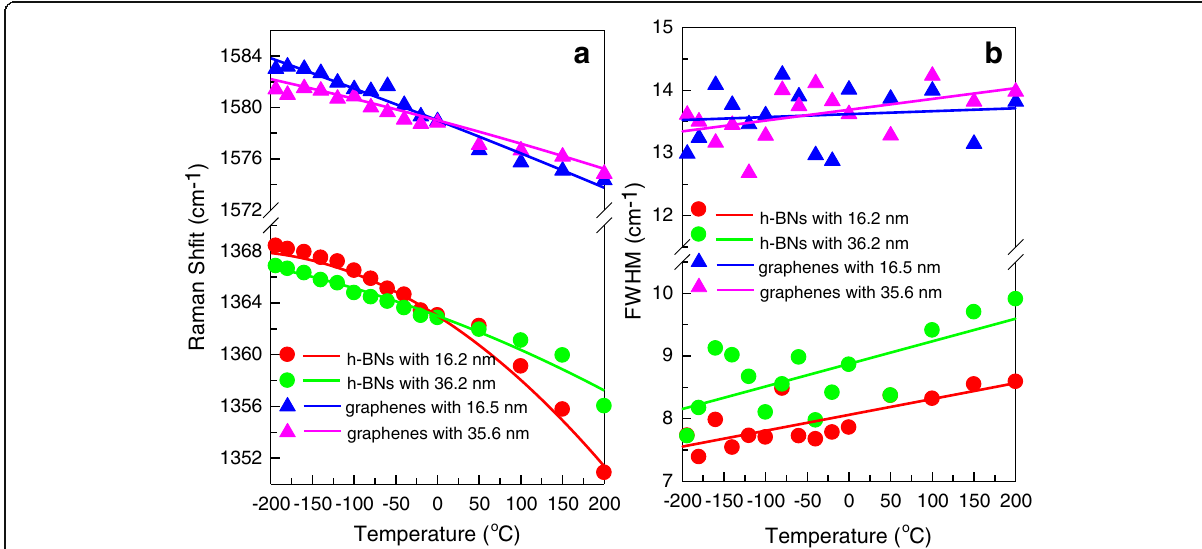
Fig. 4 a , b The Raman shift and FWHM of E 2ghigh peaks in h-BN flakes and G peaks in graphene flakes for the temperature range of − 194 ~ 200 °C